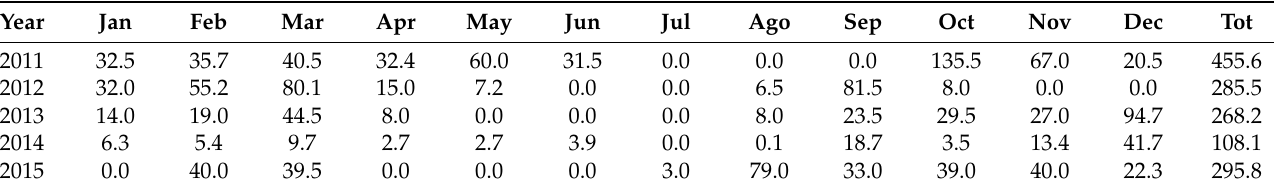
Table 1. Average monthly rainfall (mm) in Chott Mariem,